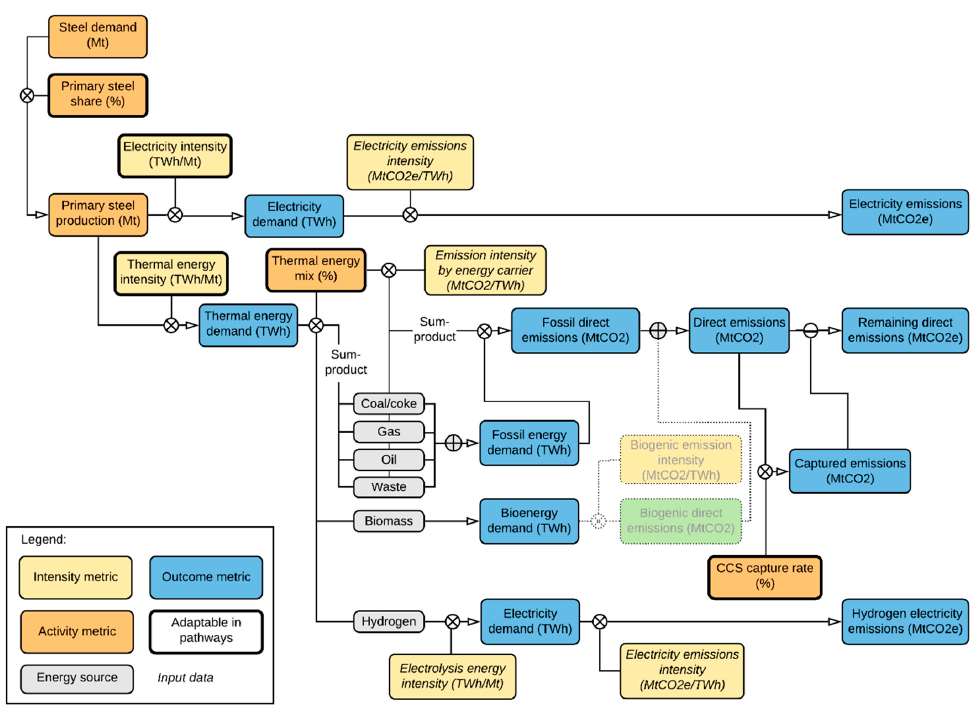
Figure 4. Schematic illustration of the calculation of emissions and energy demand per energy source for steel production. Boxes linked with an encircled x are multiplied, a box linked via an encircled minus sign is subtracted, and boxes linked with an encircled plus sign are added up. Boxes with thick outlines are metrics that are adaptable over time in the pathways depending on the abatement measures applied, while boxes with cursive texts are input data provided in Table A1, Table A2, and Table A3 in Appendix A. The initial material demand figure is only adaptable in the sensitivity analysis. Blue boxes are result figures.